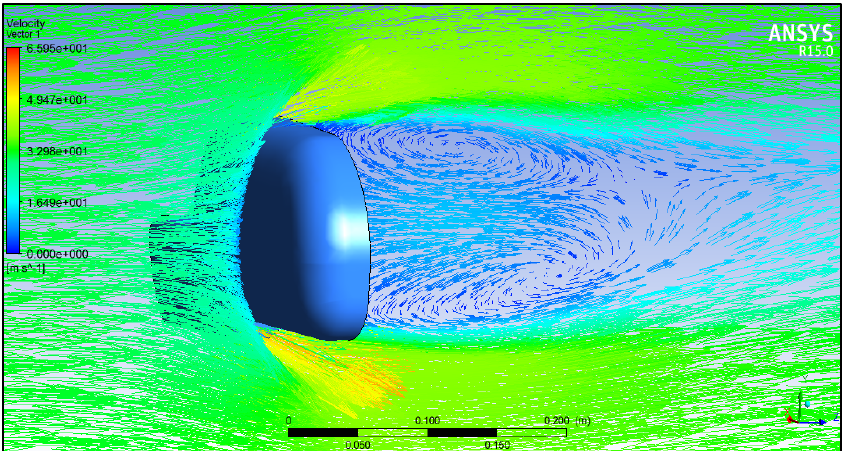
Figure 12. Velocity contures of current Tiba mirror (120